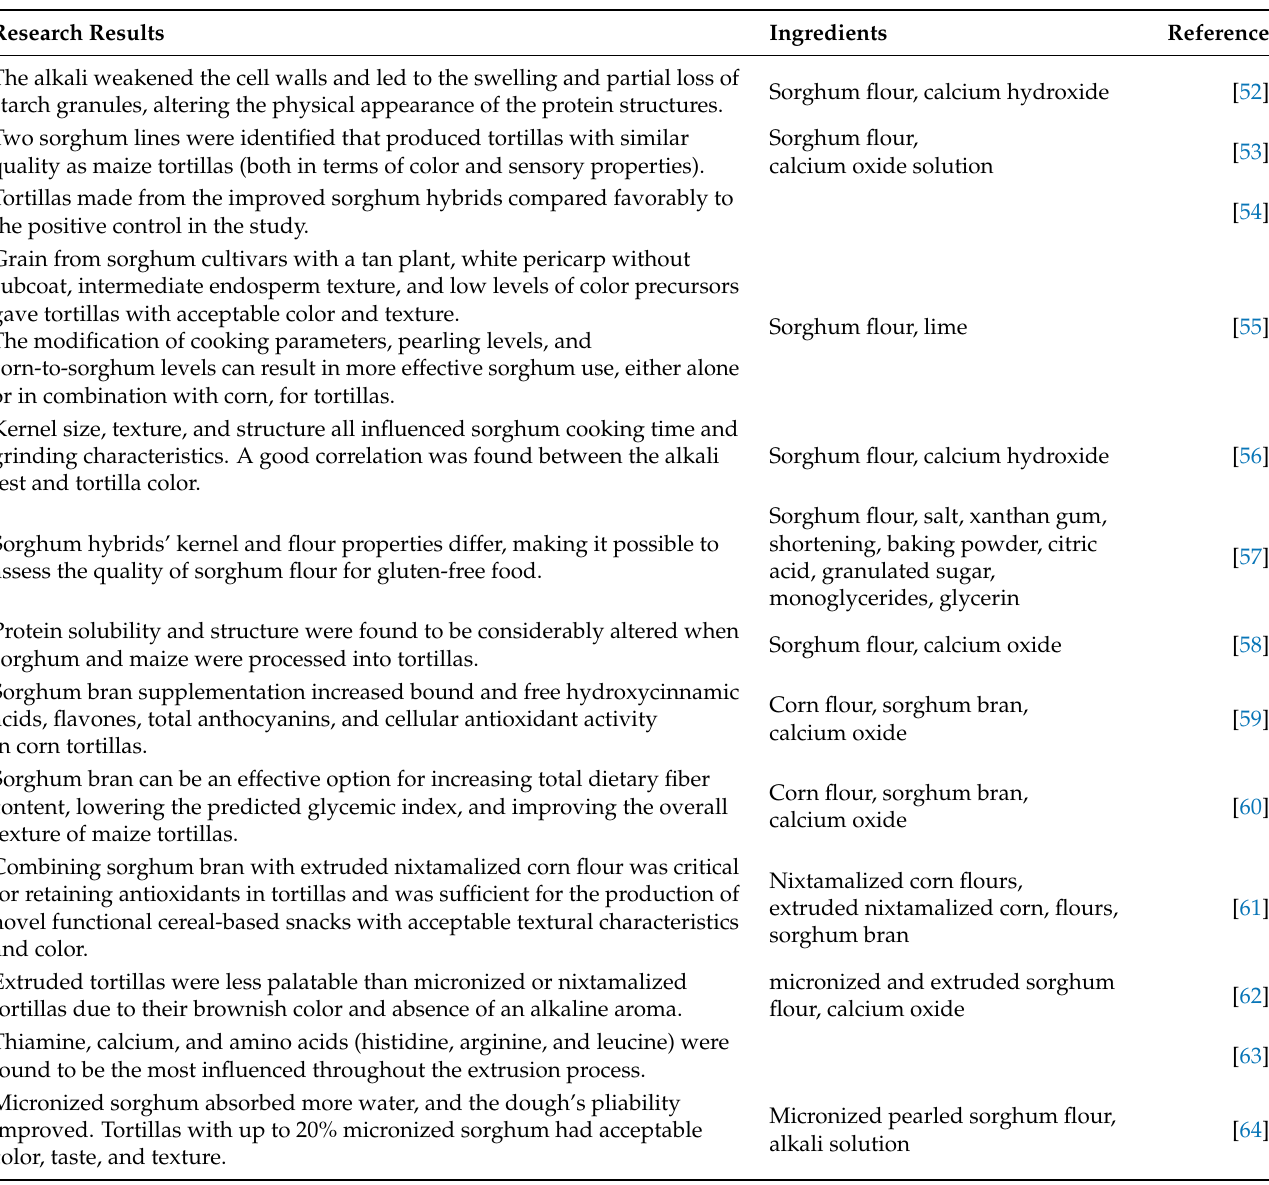
Table 2. The results of studies conducted on sorghum-based